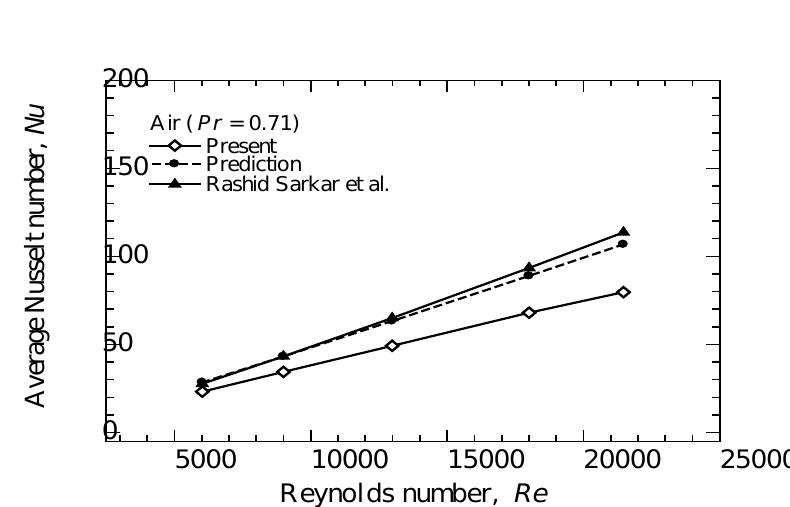
Figure 13: Prediction of heat transfer coefficients for wire-coil inserted tube (Pitch, P c = 12 mm, helix angles, α = 10 0 ).